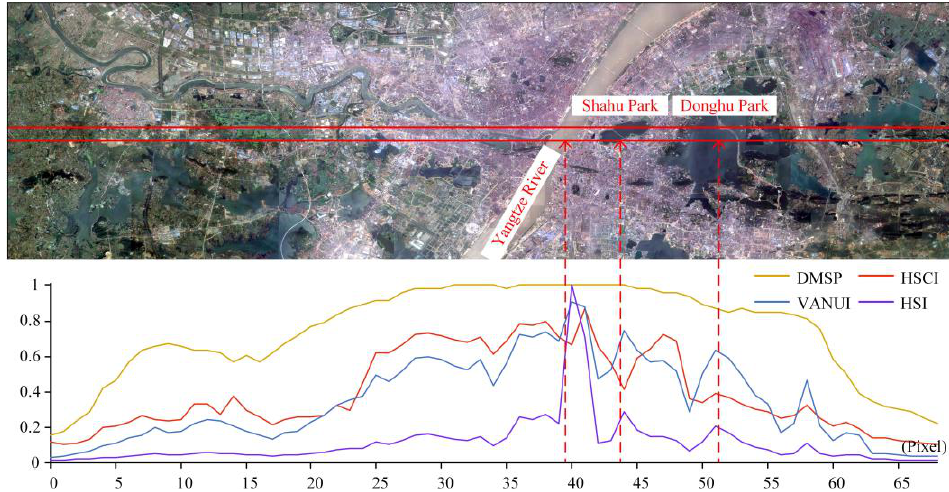
Figure 7. Longitudinal transects of DMSP (normalized), HSCI, vegetation adjusted NTL urban index (VANUI), and HSI across Wuhan.